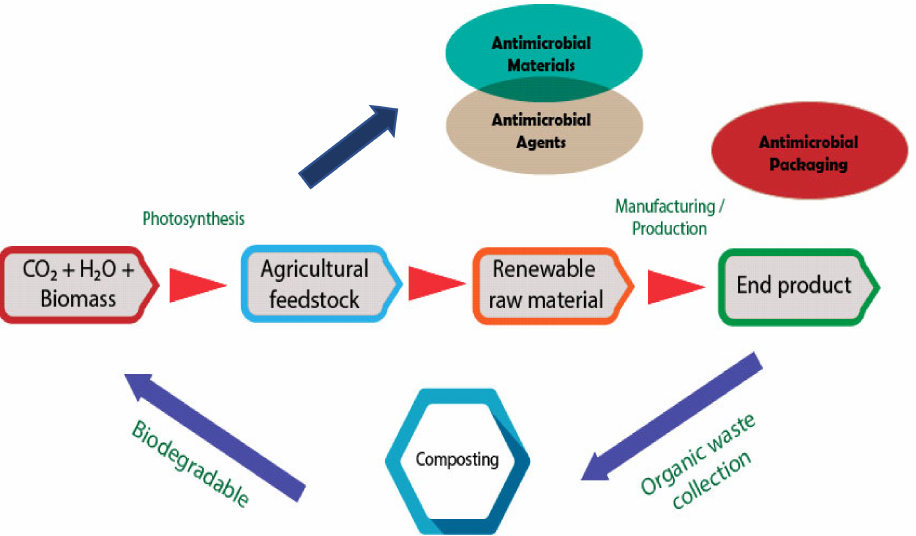
Figure 8. Interrelated antimicrobial packaging towards environmental